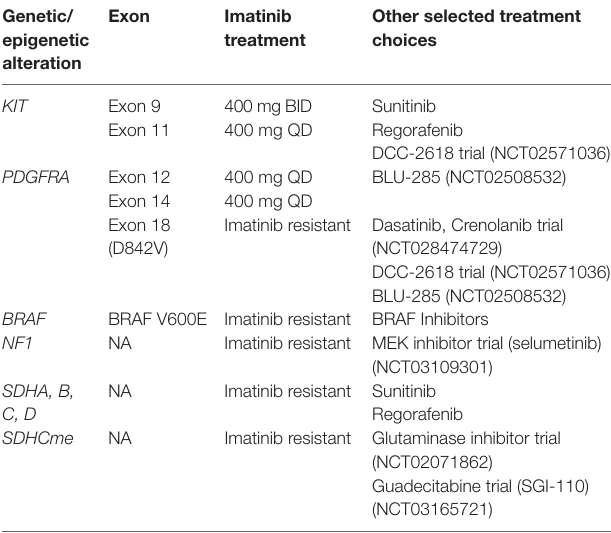
TABLe 2 | Genotype specific gastrointestinal stromal tumor treatment options. Genetic/ exon imatinib Other selected treatment epigenetic treatment alteration